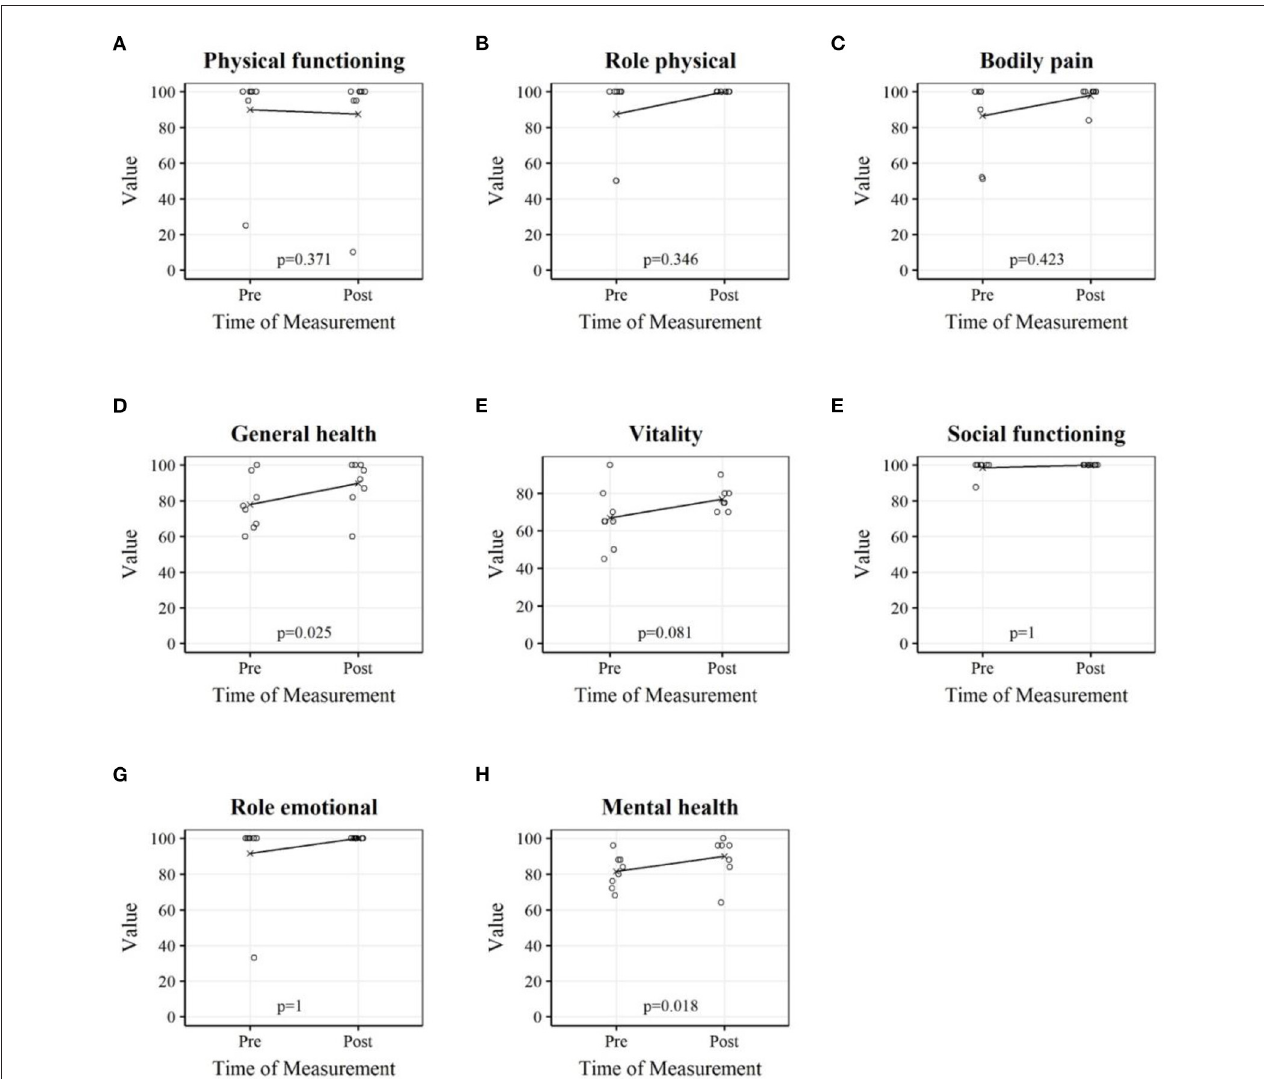
FIGURE 3 | Subscales of health-related quality of life (SF-36) of professional youth soccer players before and after the home training period. Each plot depicts the players’ individual measurements as well as the mean. Physical functioning (A) ; Role physical (B) ; Bodily pain (C) ; General health (D) ; Vitality (E) ; Social functioning (F) ; Role emotional (G) ; Mental health (H)